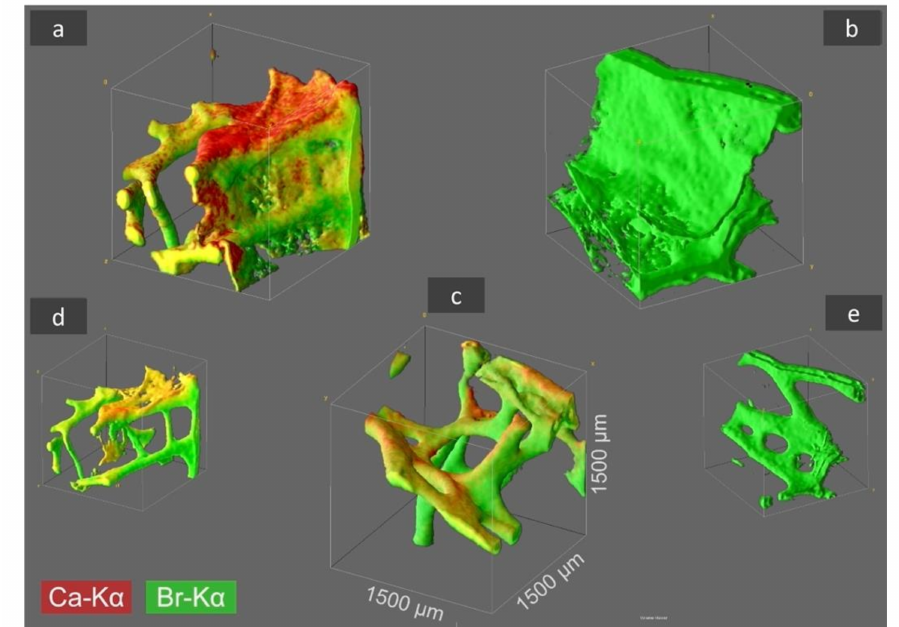
Figure 2. C µ XRF analysis results of selected I. basta skeletal samples after treatment with distilled water ( a ), 3 M HCl ( b ), and 10% NaOH at 40 ◦ C ( c ). The 3D distribution of Ca (red) and Br